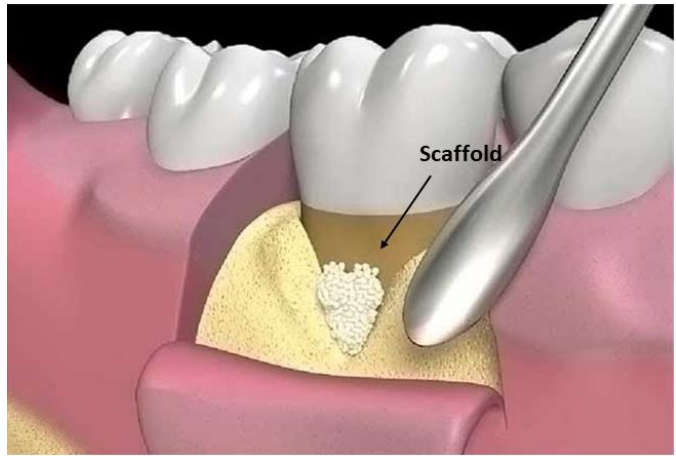
Figure 8. Scaffold and its placement .